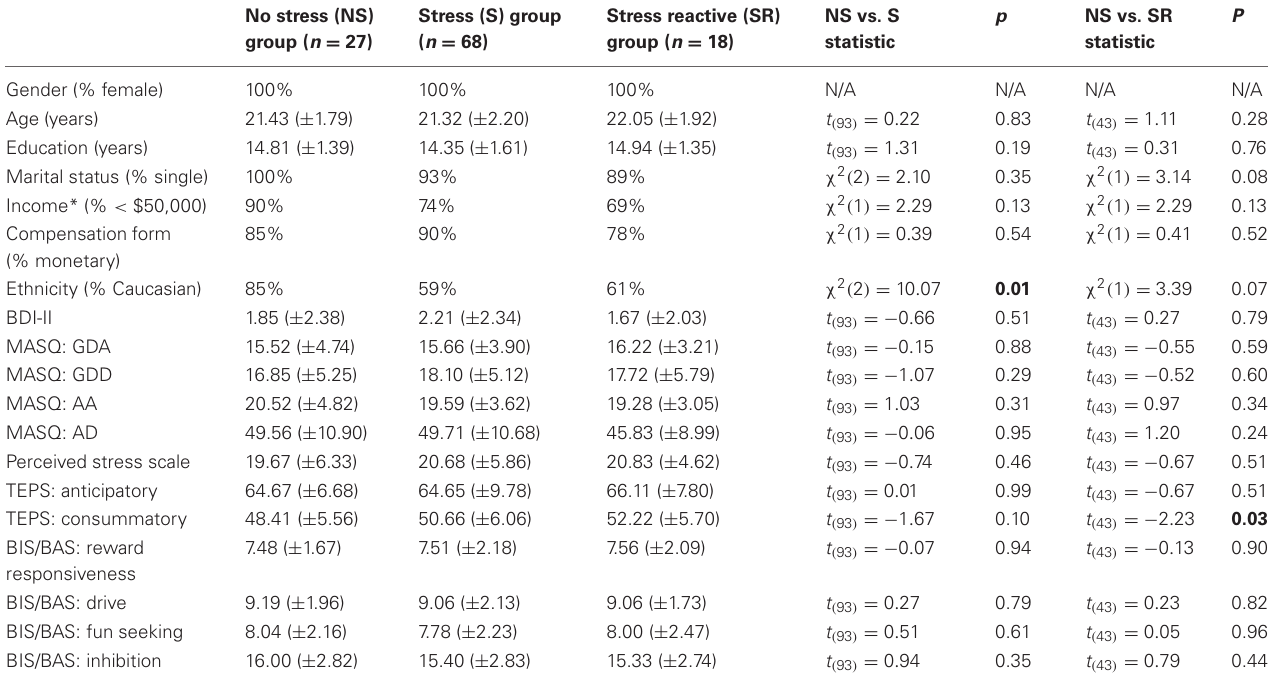
Table 1 | Demographics, trait and dispositional self-report measures by